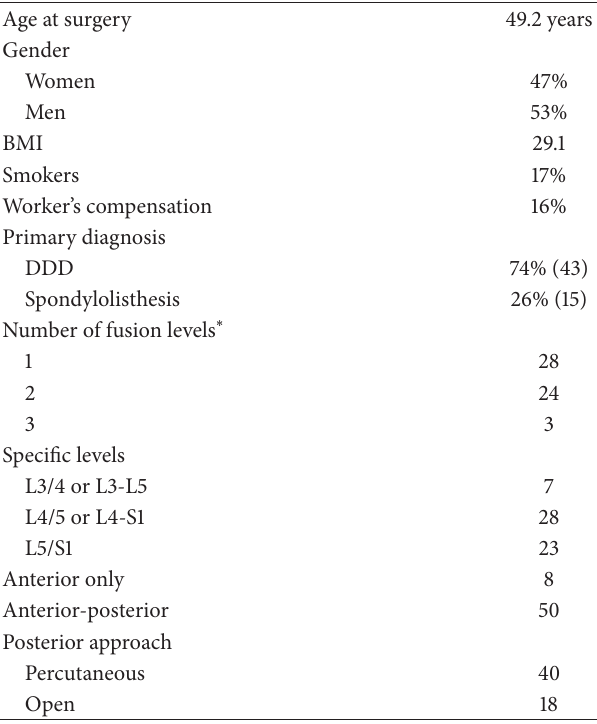
Table 1: Patient demographics.